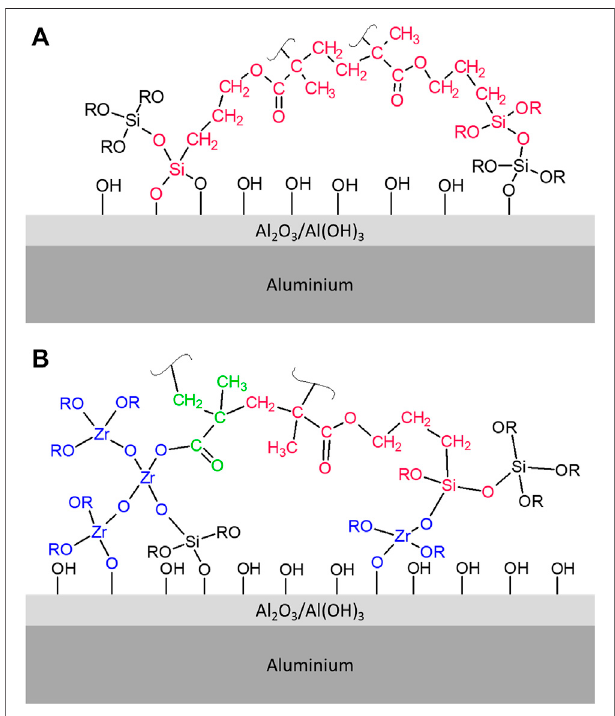
FIGURE4| Schematicpresentationofthesol-gelnetworkin (A) TMand (B) TMZ coatings deposited on the aluminium surface.